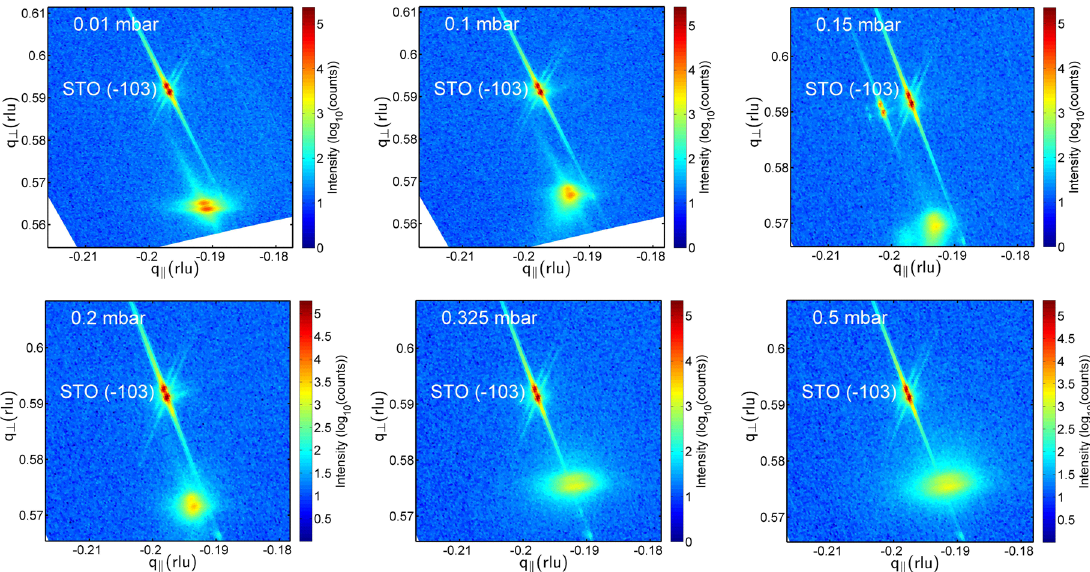
Figure 3. XRD reciprocal space maps around the asymmetric 103 SrTiO 3 substrate peaks (in the Figures referred to as STO ( − 103)) of the BaTiO 3 ‐ BiFeO 3 composite films grown at the indicated oxygen partial pressures. The lower intensity film peaks are at the bottom. With increasing oxygen pressure, the film peaks broaden, i.e. , the composite mosaicity increases. However, film ‐ to ‐ substrate peak separation decreases. Note that the vertical q ┴ axis for the two lowest pressures is enlarged. As is visible from the increasing vertical misalignment of film and substrate peaks with increasing growth pressure, the film relaxation increases. The 0.15 ‐ mbar sample shows substrate and corresponding crystalline film domains. The peak splitting is due to the K α 1/2 radiation used.